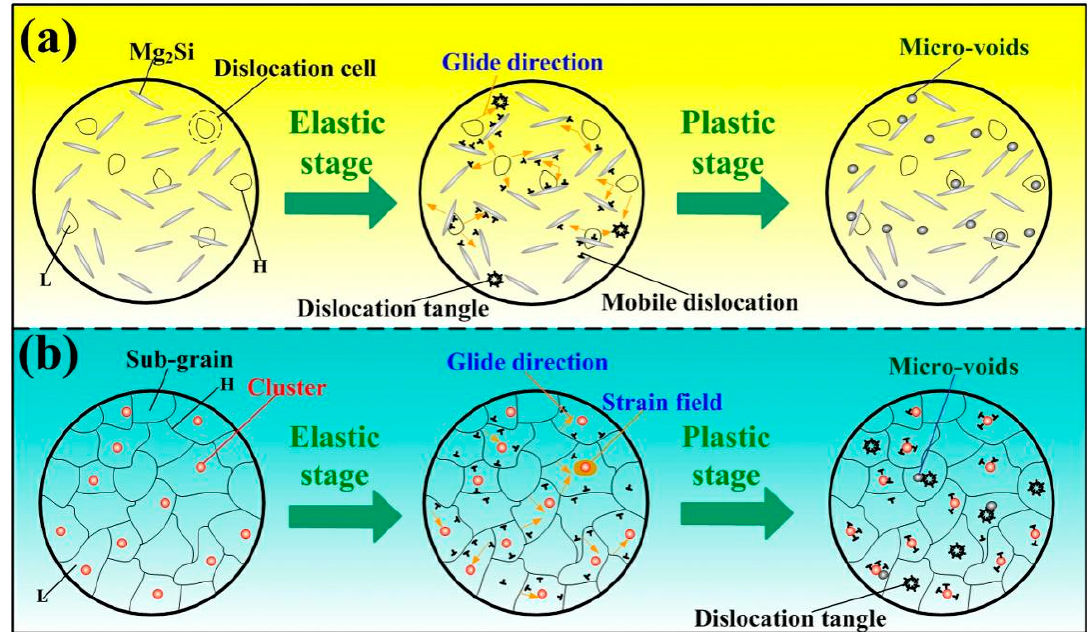
Figure 11. The schematic reveals the interaction of dislocation and precipitation in different states: ( a ) T6, ( b ) S + EA (L: low dislocation density, H: high dislocation density). ( a ) T6, ( b ) S + EA (L: low dislocation density, H: high dislocation